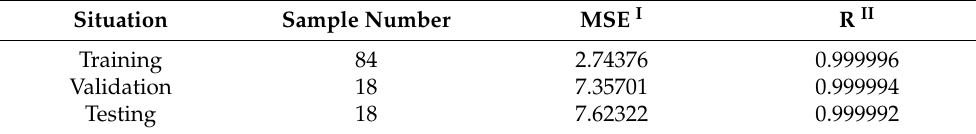
Table 4. Performance of the neural network during training and validation.